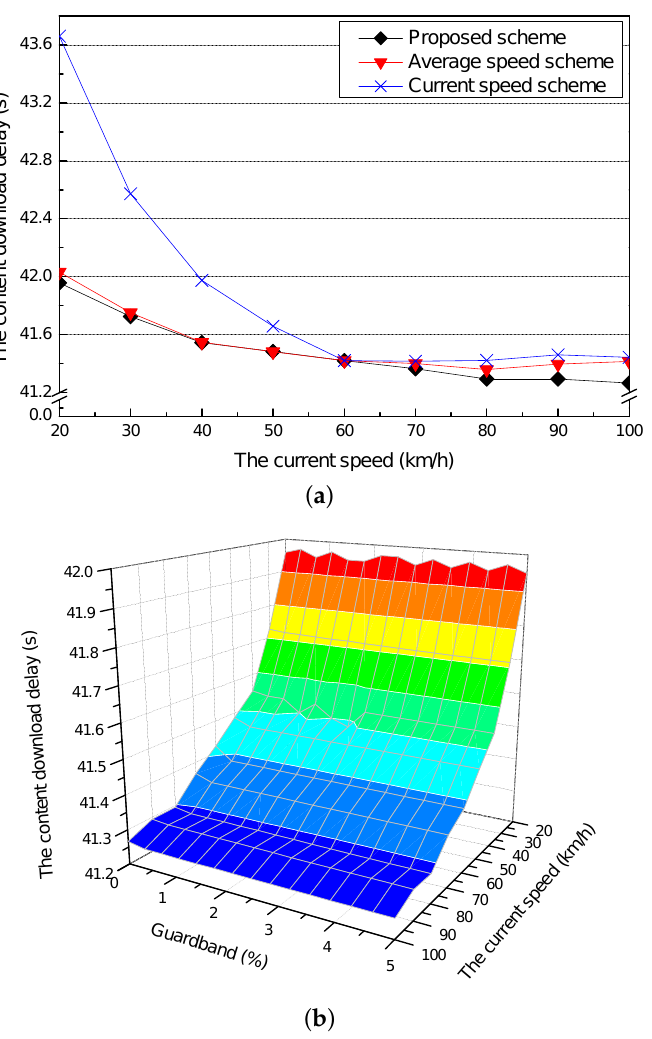
Figure 7. Simulation results for the different current speeds: ( a ) the content download delay and ( b ) the content download delay for different